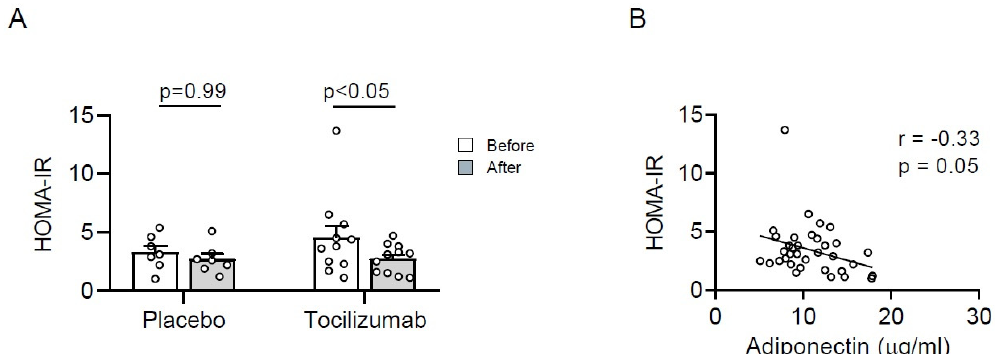
Figure 2. Tocilizumab administration decreases HOMA-IR in people with obesity. HOMA-IR was determined in people with obesity, with or without type 2 diabetes, receiving placebo ( n = 7) or tocilizumab administration ( n = 11) before (open bars) and after 12 weeks (grey bars) of administration. Data are displayed as absolute values ( A ) over the 12-week administration period. Values are expressed as mean ± SEM. ( B ) Scatter plot and correlation coefficient (r) of circulating adiponectin concentration and HOMA-IR before and after 12 weeks of administration in people with obesity, with or without type 2 diabetes, receiving placebo or